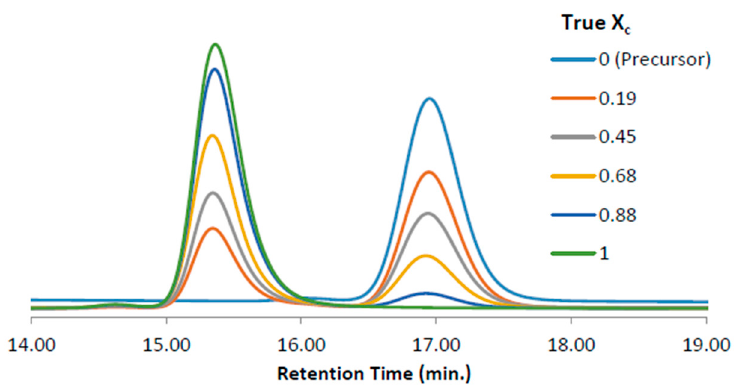
Figure 3. GPC traces of PS standards mixed to mimic varying extents of coupling, as listed in Table 2. Table 2. Percent “Coupling” Calculations of Mixed PS Standards 17,500:50,000 a .